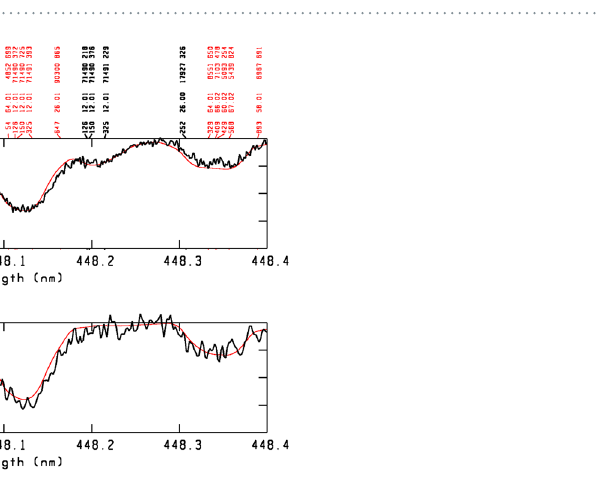
Figure 4. Comparison of the chemical composition of HD 66051 (red stars) to the abundance patterns observed in the HgMn stars HD 49606 (pink circles), HD 175640 (blue diamonds) [upper panel] and the HgMn-related, highly peculiar star HD 65949 (green diamonds) [lower panel]. Odd- Z elements and even- Z elements are denoted by, respectively, open and filled symbols.